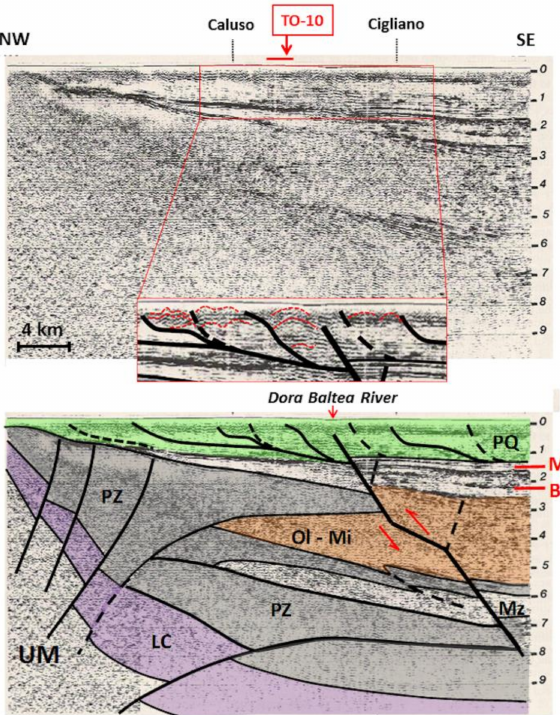
Figure 3. Internal section of the ECORS-CROP project (also known as CROP ALP-1) along the align- ment Castellamonte-Caluso-Lamporo. The TO-10 site location is shown in red. Original data from Roure et al. [26] have been revisited and reinterpreted also in the light of [43]. It can be noticed that the major fault ceases right below the Dora Baltea River scarp. The indication referring to “Cigliano” is the perspective reference from the point of view (located within the SW quadrant). The inset provides details of the structural setting (see text). PQ: Plio-Quaternary; M: Messinian; B: Burdigalian-Tortonian; Ol-Mi: Oligocene-Miocene (Gonfolite); PZ: South Alpine retrovergent units; LC: Lower Crust (granulites and related rocks of the Ivrea Zone); UM: Upper lithospheric Mantle. Major faults: thick black lines, dashed were approximate.